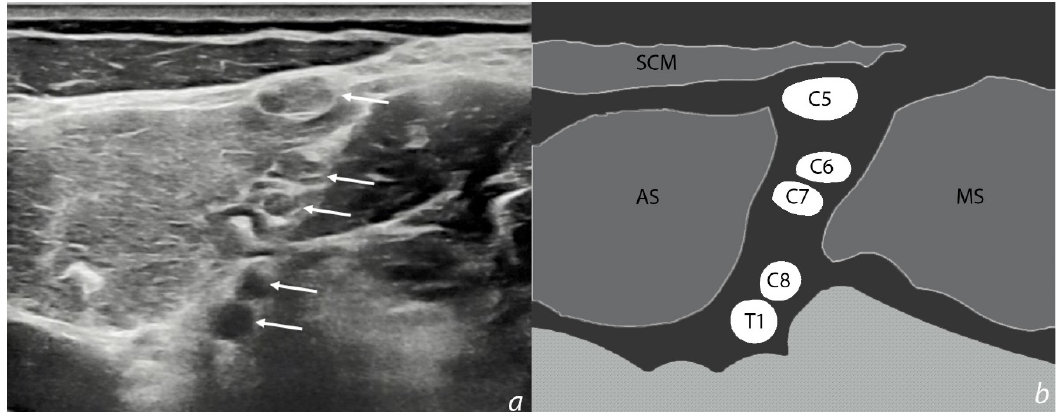
Figure 4. Ultrasound image of the interscalene groove in supraclavicular laterocervical region. Cervical spinal nerves (ventral rami) forming the brachial plexus pass through the anatomical space between anterior and middle scalene muscles, before they merge to form the upper, middle, and lower trunks. ( a ) Ultrasound image. White arrows indicate cervical spinal nerves (ventral rami); ( b ) schematic representation of the interscalene groove. C5 is the most superficial cervical spinal nerve, immediately below the sternocleidomastoid muscle. C5: cervical spinal nerve 5. C6: cervical spinal nerve 6. C7: cervical spinal nerve 7. C8: cervical spinal nerve 8. T1: thoracic spinal nerve 1. SCM: sternocleidomastoid muscle, AS: anterior scalene muscle, MS: middle scalene